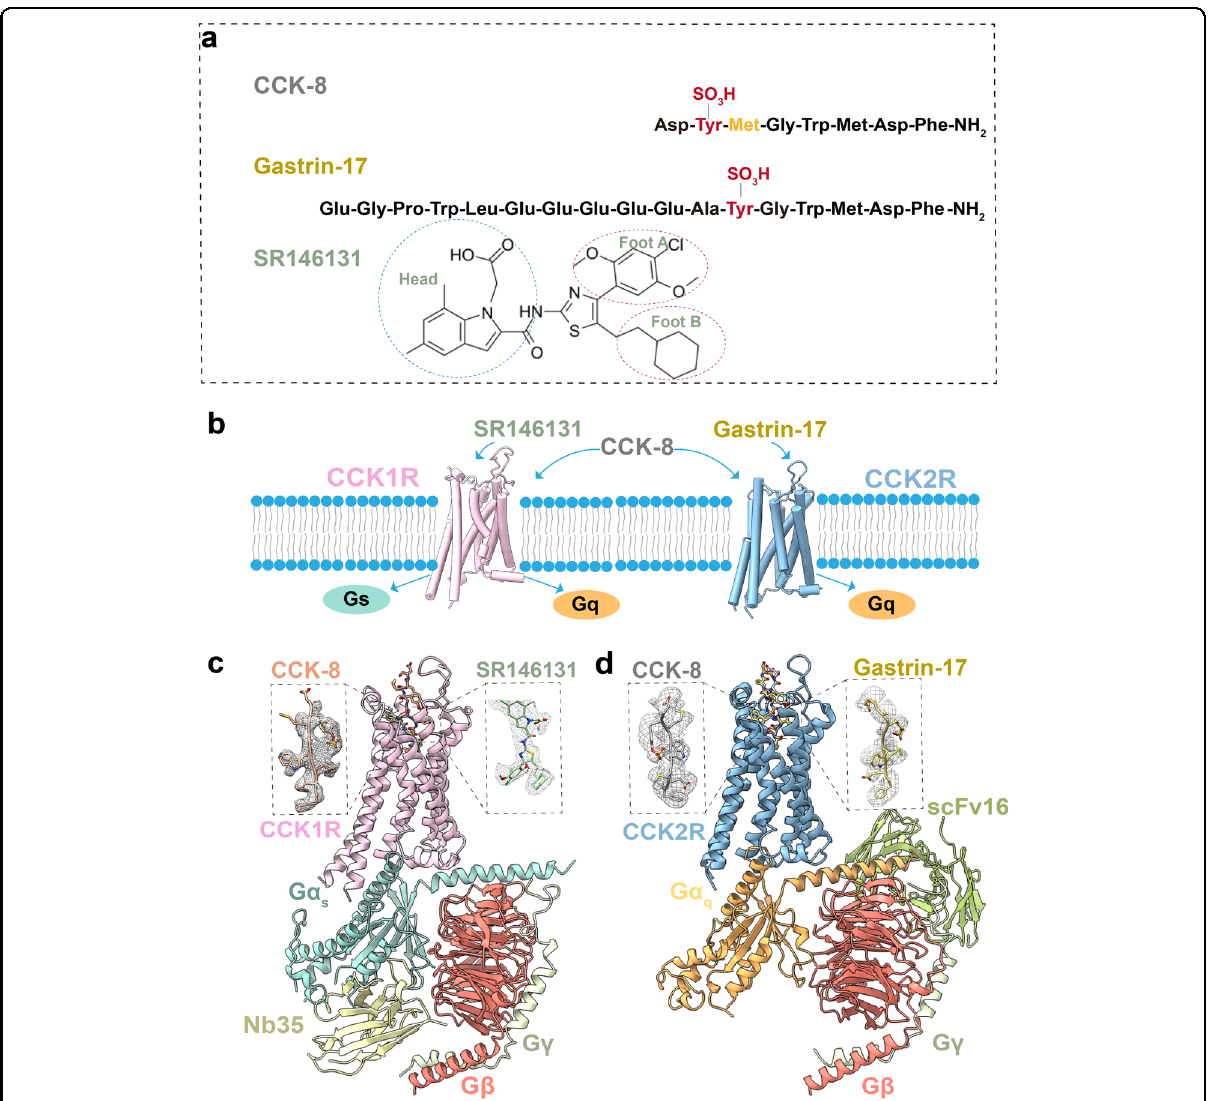
Fig. 1 Overall structures of CCK1R and CCK2R signaling complexes. a Molecular formula of CCK-8, gastrin-17, and SR146131. Sulfated tyrosines are colored red and the amino acid differs between gastrin-17 and CCK-8 is colored orange. b Schematic diagram showing various ligands signaling through CCK1R and CCK2R. c , d Representation of CCK-8-bound CCK1R – G s complex and SR146131-bound CCK1R – G s complex. CCK1R, pink; CCK-8, sienna; SR146131, dark sea-green; G α s , cyan; G β , salmon; G γ , beige; Nb35, light yellow ( c ). Representation of CCK-8-bound CCK2R – G q complex and gastrin-17-bound CCK2R – G q complex. CCK2R, blue; CCK-8, gray; gastrin-17, yellow; G α q , orange; G β , salmon; G γ , beige; scFv16, lawn green ( d